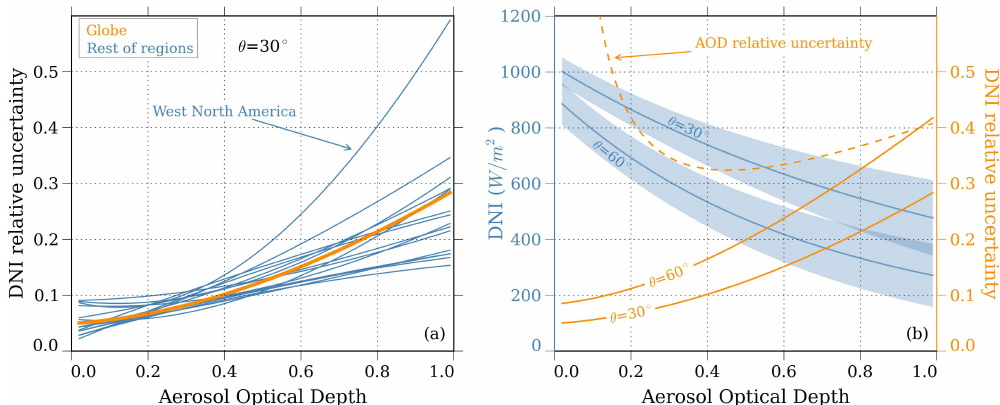
Fig. 8. (a) Relative uncertainty in DNI for each region as a function of AOD, for the entire dataset and for θ = 30 ◦ . (b) Magnitude (blue) and relative DNI uncertainty (orange) for the entire dataset for θ = 30 ◦ and θ = 60 ◦ . The blue-shaded area is the DNI uncertainty in Wm − 2 . The blue line is for the DNI value. Also shown is the AOD’s relative uncertainty (dashed line).